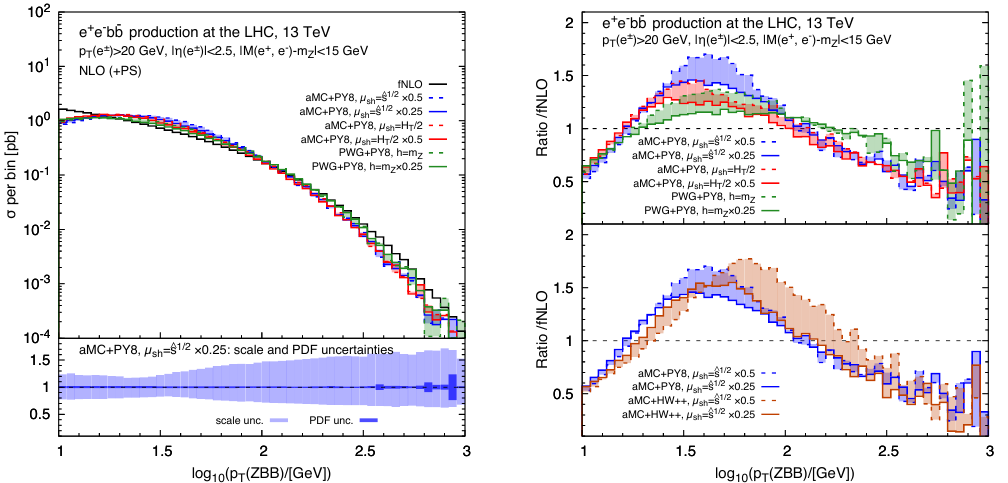
Figure 5 . Transverse momentum distribution of the ‘ + ‘ (cid:0) B (cid:22) B (cid:12)nal state, computed in the 4FS. In the plot we represent the log( p ? ( ‘ + ‘ (cid:0) B (cid:22) B )) distribution. The left plot shows the distribution in di(cid:11)erent approximations; the lower inset shows the size of the corresponding PDF, factorisation and renormalisation scale uncertainty bands, with respect to the NLO prediction. The right plot shows the relative e(cid:11)ect of di(cid:11)erent approximations, with respect to the (cid:12)xed-order NLO results: di(cid:11)erent matching schemes ( MG5 aMC vs POWHEG-BOX ) with the corresponding matching- p p parameter uncertainty band, (cid:22) sh = ^ s= 2 ; ^ s= 4 or h = m = 4 ; m (lower inset); di(cid:11)erent Parton Z Z Shower models ( Py8 vs Hw++